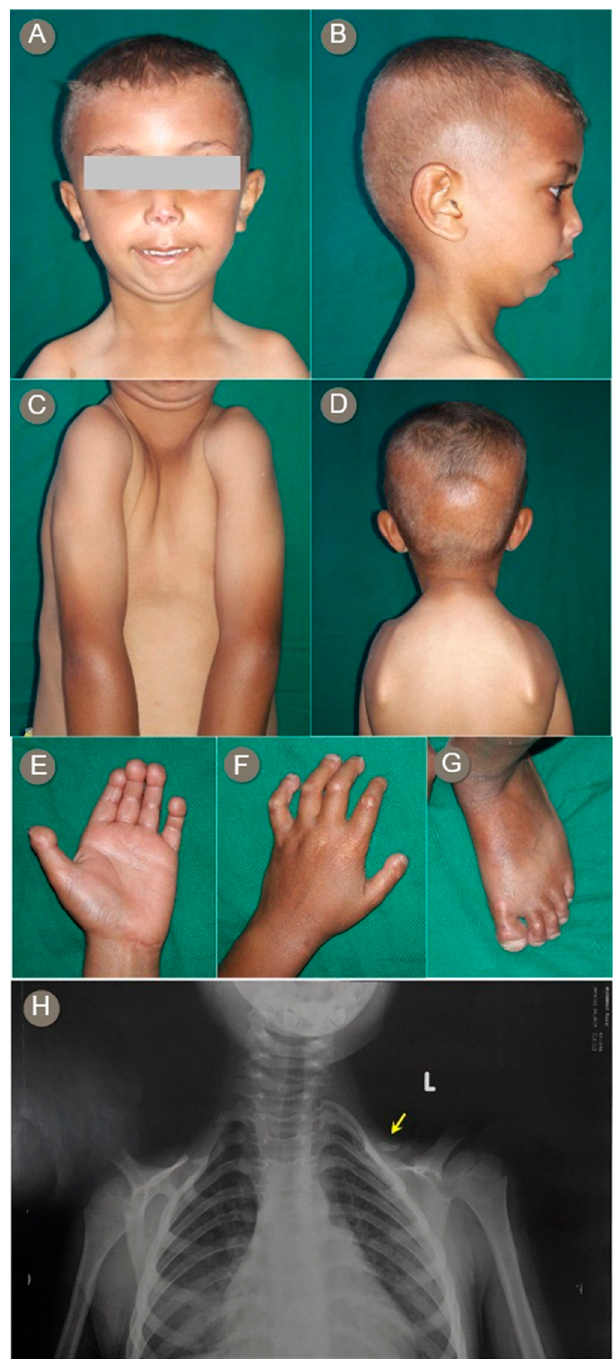
Figure 2. Proband 2 showing an oval face; wide eyes with periocular hyperpigmentation; arched eyebrows; a short, thin, upturned nose; a small mouth with limited opening ( A ); submental obesity and microretrognathia ( B ); narrow, sloping shoulders and prominent scapular wings ( C ); abnormal facility in opposing shoulders ( D ); short fingers with drumstick-shaped distal phalanges ( E ); flexed fingers with atrophic shiny overlying skin; hypopigmentation over the knuckles and broad, short, dystrophic nails ( F ); and round toe tips, nail dystrophy, and visible veins ( G ). Chest radiograph demonstrating severely hypoplastic/absent clavicles bilaterally ( H